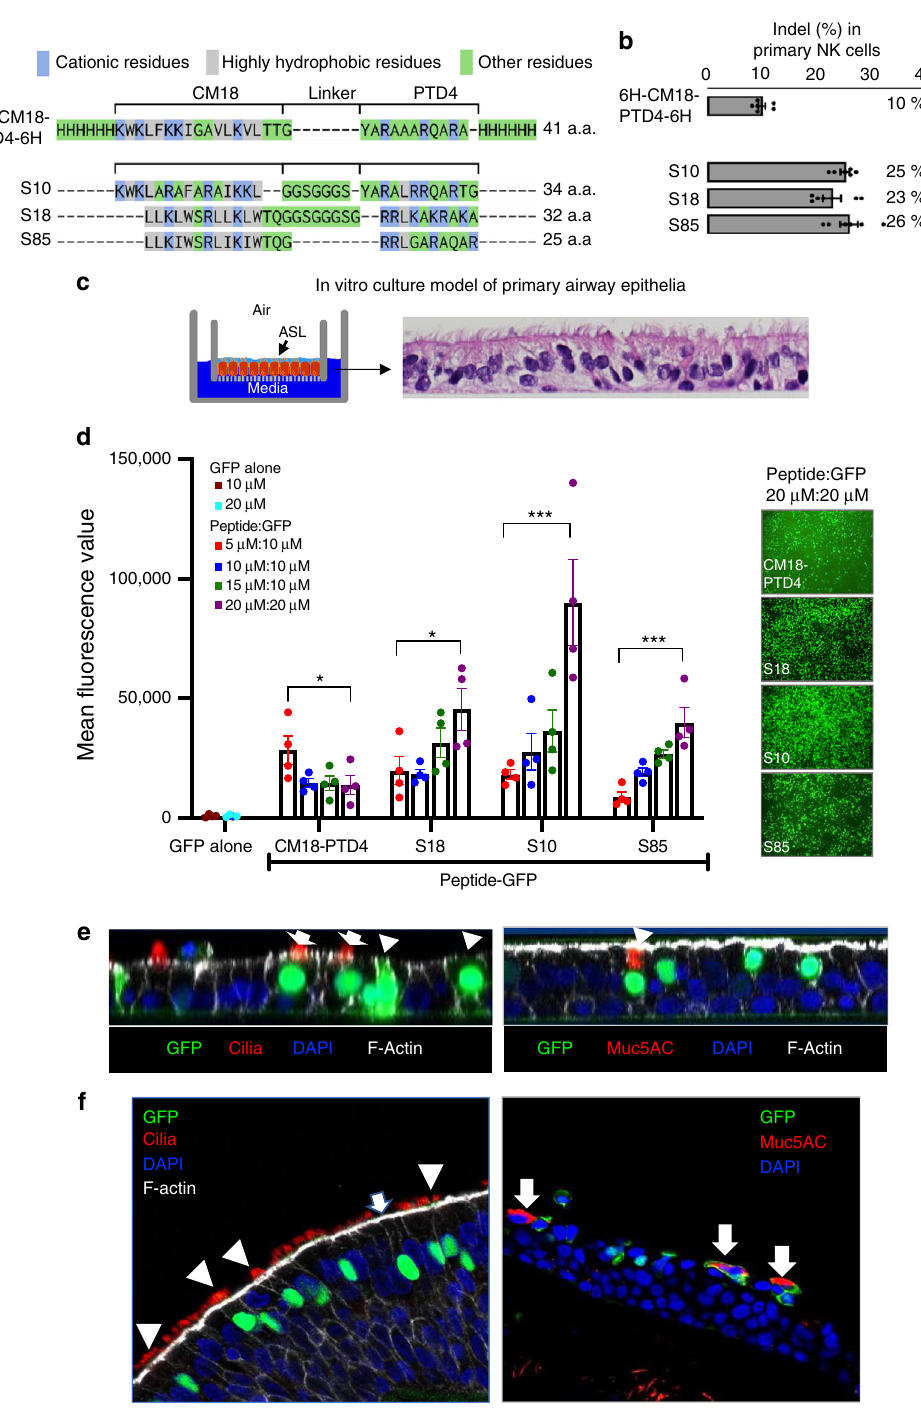
reagents and observed no editing of two different CFTR loci (Supplementary Fig.